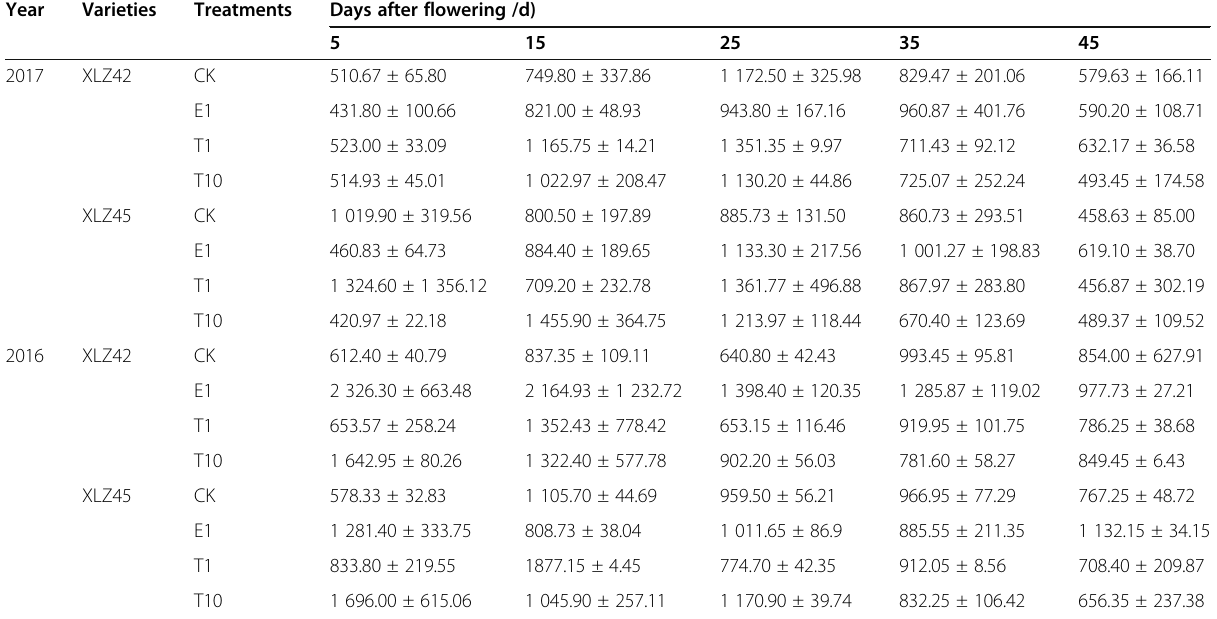
Table 5 The minimum saturating irradiance (Ik, μ mol m − 2 ·s − 1 ) of two cotton varieties (XLZ42 and XLZ45) at different days after flowering in various treatment groups: Mulch film was removed at 1 and 10 days before the first irrigation (respectively T1(June 19, 2016 and June 10, 2017), T10(June 9, 2016 and May 31, 2017)) and 1 day before the second irrigation (E1(June 29, 2016 and June 20, 2017)) after seedling emergence, during 2016 – 2017. The control group (CK) had film mulching throughout the growth stages. Values are means ± standard deviation (n =